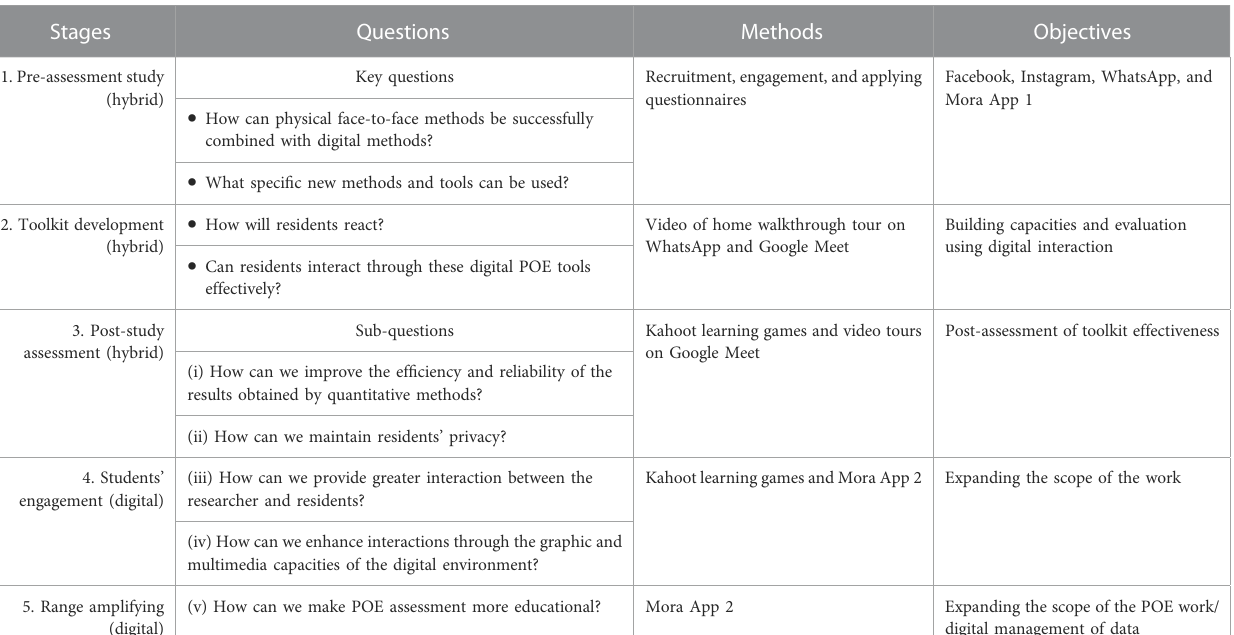
TABLE 1 Stages, digital methods, and objectives of the